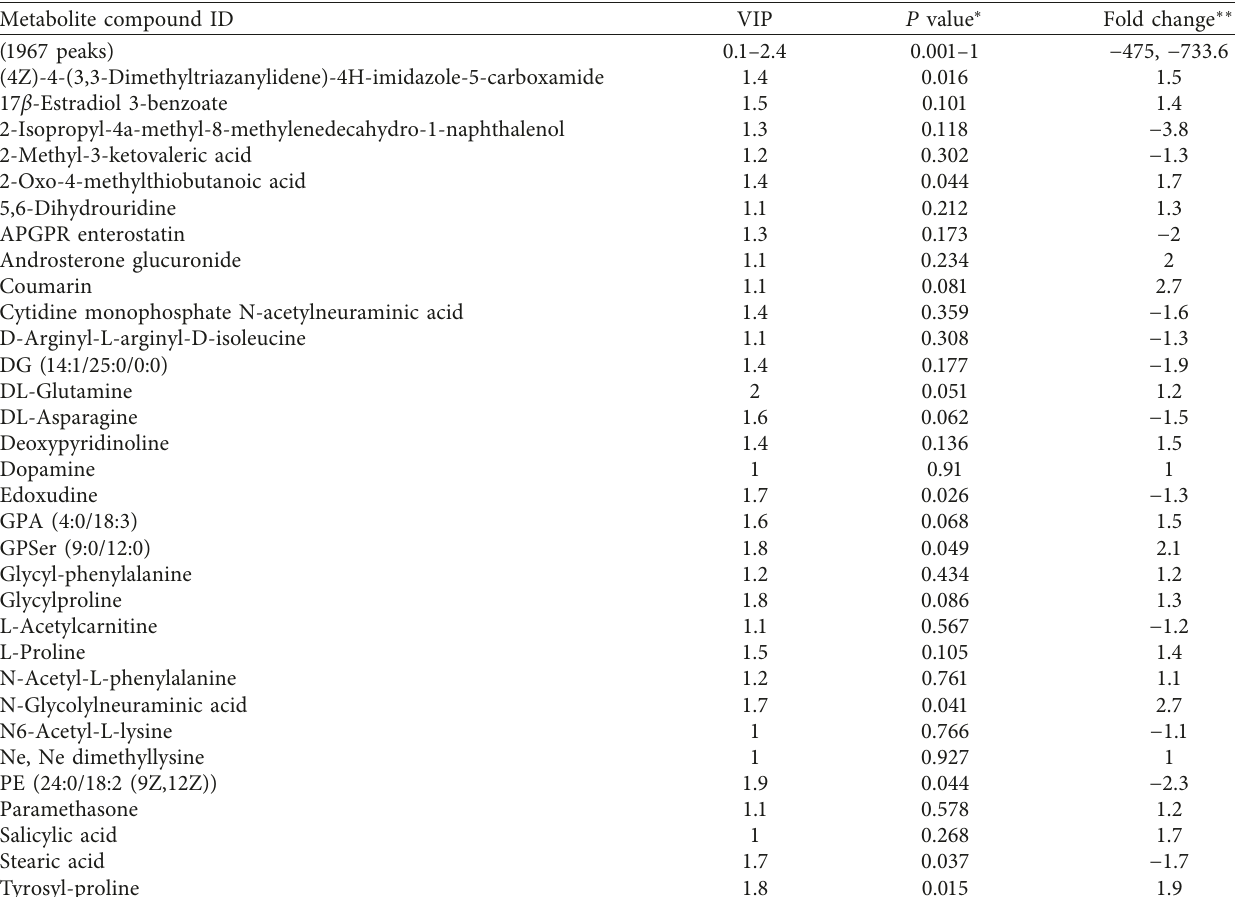
Table 2: Summary of salivary metabolites differentially expressed in poorly controlled vs. well-controlled type I diabetes. Metabolite compound